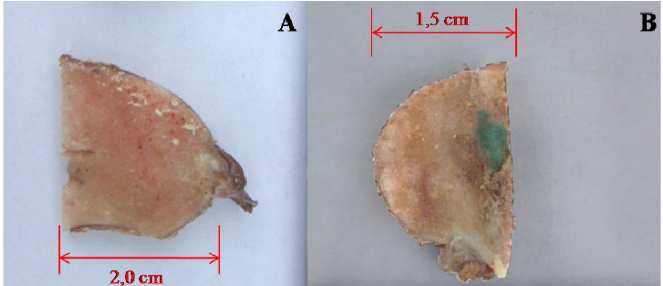
FIGURE 4 – Representative figure of expression of the reporter gene LacZ is evidenced by ß-Gal staining in the femoral head of ovines. A. Ovine femoral head control (Health limb). B. Experimental expressing LacZ.